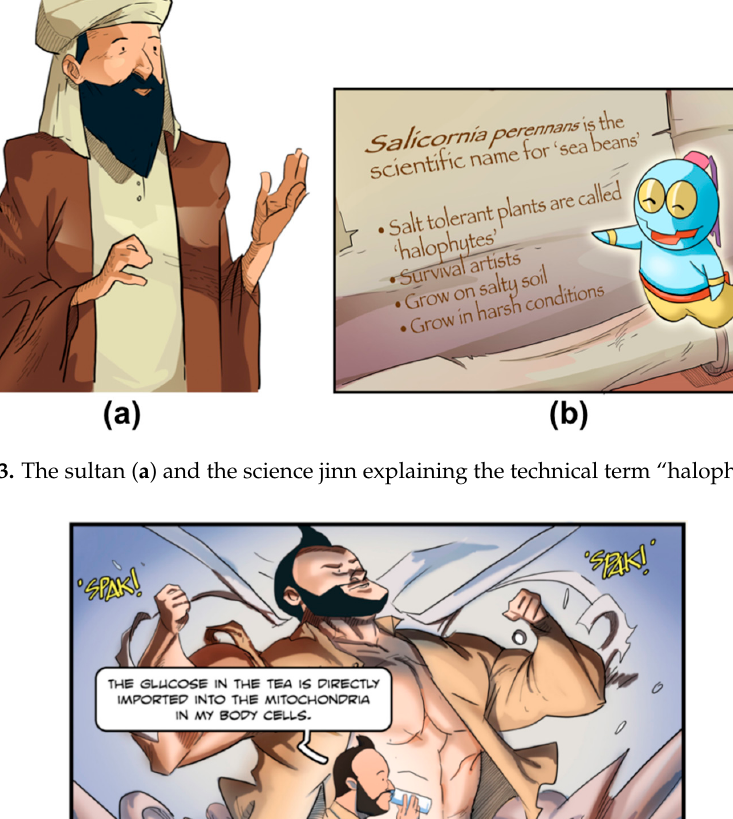
Figure 3. The sultan ( a ) and the science jinn explaining the technical term “halophytes” ( b ).